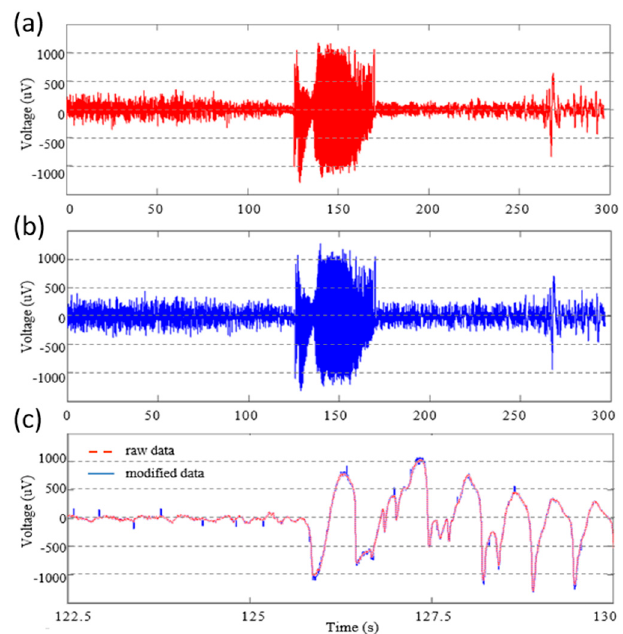
Figure 11. Example explaining the effects of supply voltage variations by using a seizure segment. ( a ) A raw seizure segment, ( b ) data in which distortions caused by supply voltage variations and noise were reflected, and ( c ) zoomed-in data of ( a , b ).